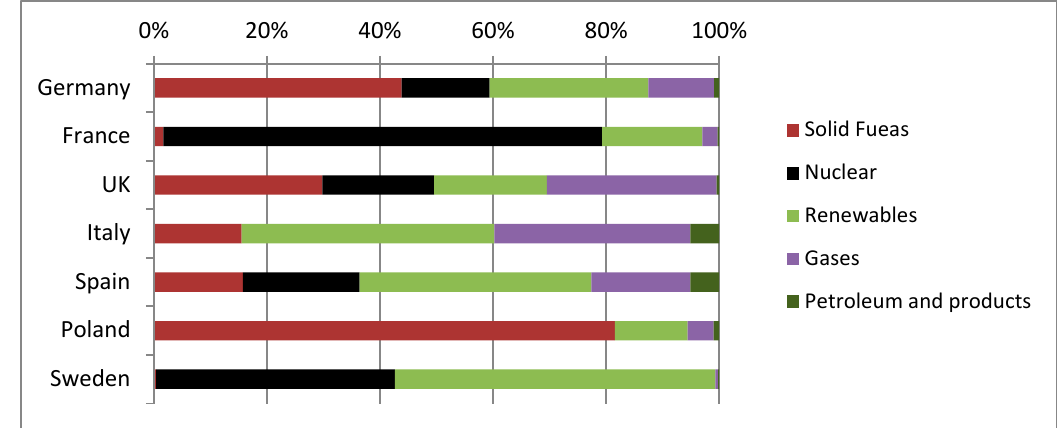
Figure 1. The structure of fuel use in 2016 in selected EU countries (own study).